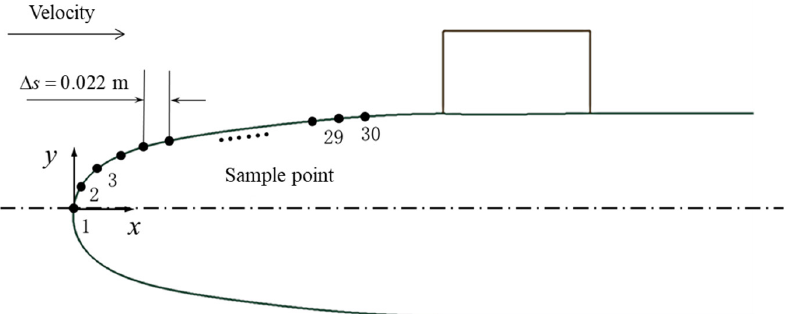
Figure 12. The position of the axial sample points.